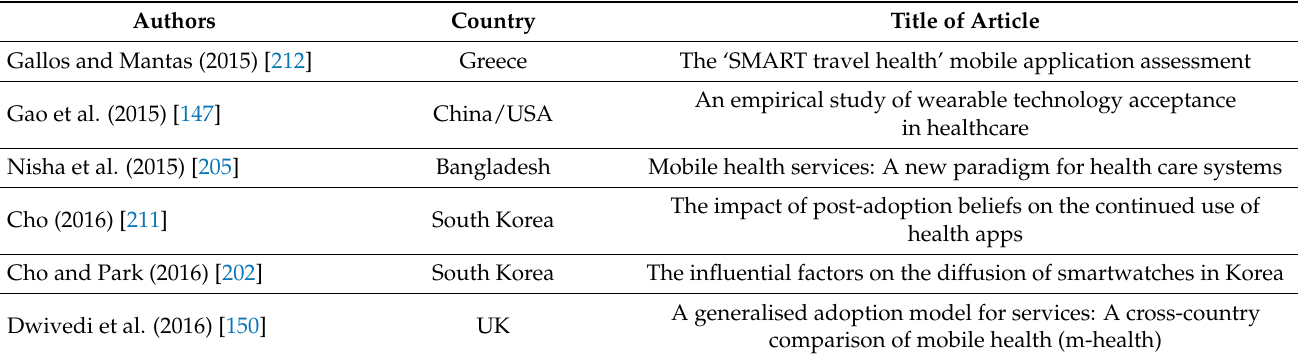
Table A2. List of Articles Considered with Their Respective Years of Publication and Country